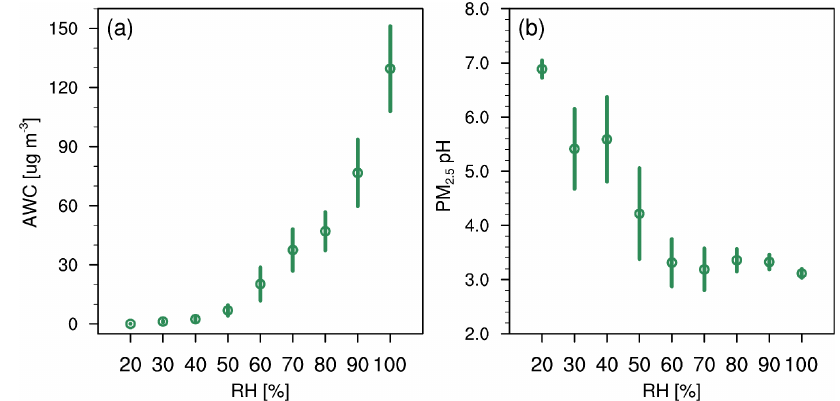
Figure 10. (a) AWC (µgm − 3 ) and (b) PM 2 . 5 pH predicted by the CTL3meta scenario as a function of RH for data at the Beijing site during the study period of 15 October–2 November 2014. Data are grouped in RH bins (10% increment). The error bars represent the standard deviations.